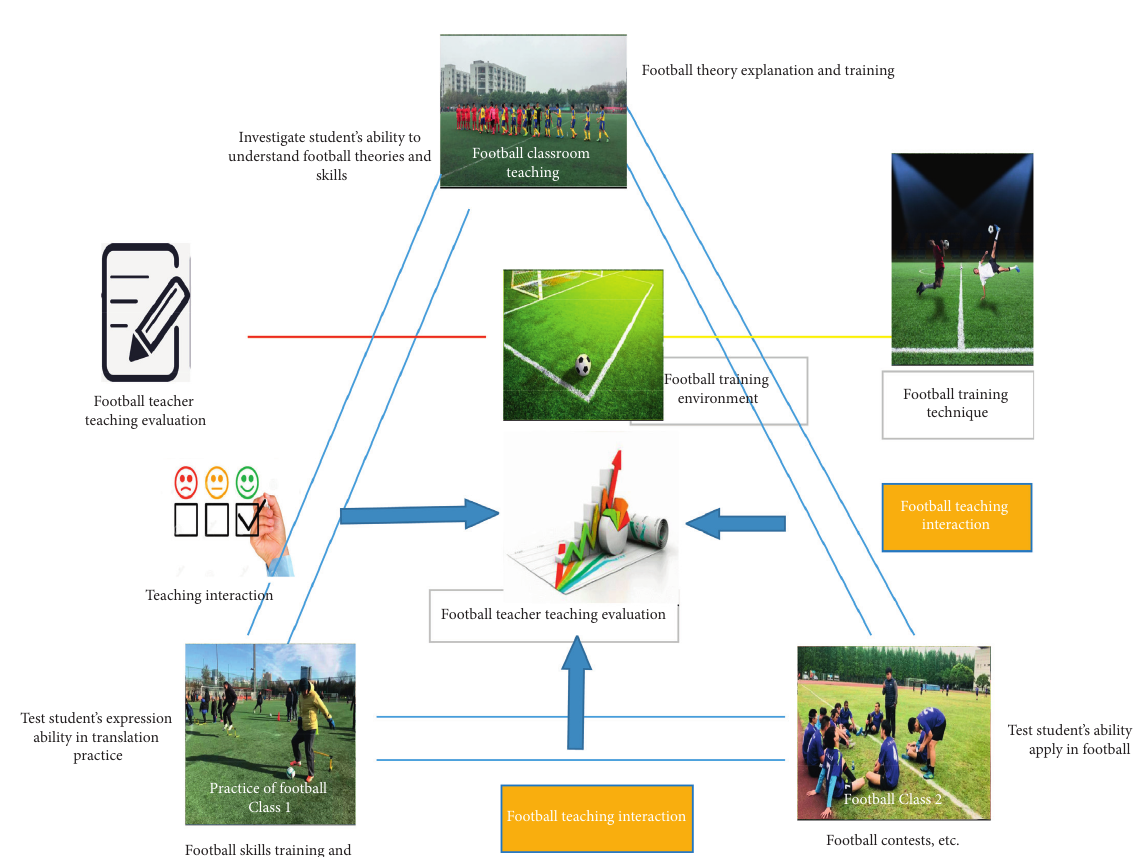
Figure 2: Schematic diagram of teaching evaluation of football teachers.